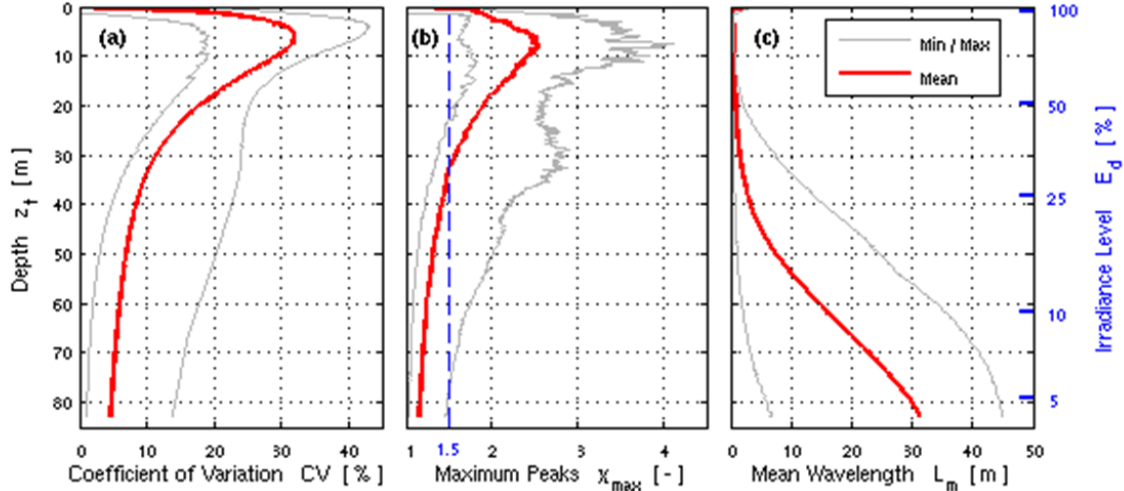
Fig. 10. Summary of light field statistics of all sea states under consideration with the dx = 10cm model; the grey lines show the respective minimum and maximum values, the red lines present the average of the values due to the sea states with highest occurrence probability (in the white framed in Fig. 2); (a) : coefficient of variation CV ; (b) : maximum normalized downwelling irradiance χ max ; (c) : mean fluctuation length L m .